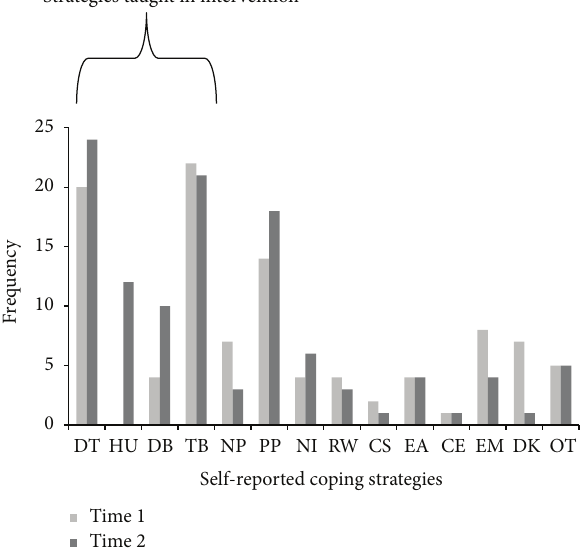
Figure 1: Frequencies for participants’ ( 𝑛 = 71 ) self-reported coping strategies at Time 1 and Time 2. DT = distraction; HU = humour; DB = deep breathing; TB = use teddy bear; NP = nonphysical parental involvement; PP = physical parental involvement; NI = nonparental physical involvement; RW = reward; CS = coping statement; EA = eating; CE = close eyes; EM = emotions; DK = do not know/nothing; and OT = other. The first four strategies were taught in intervention.